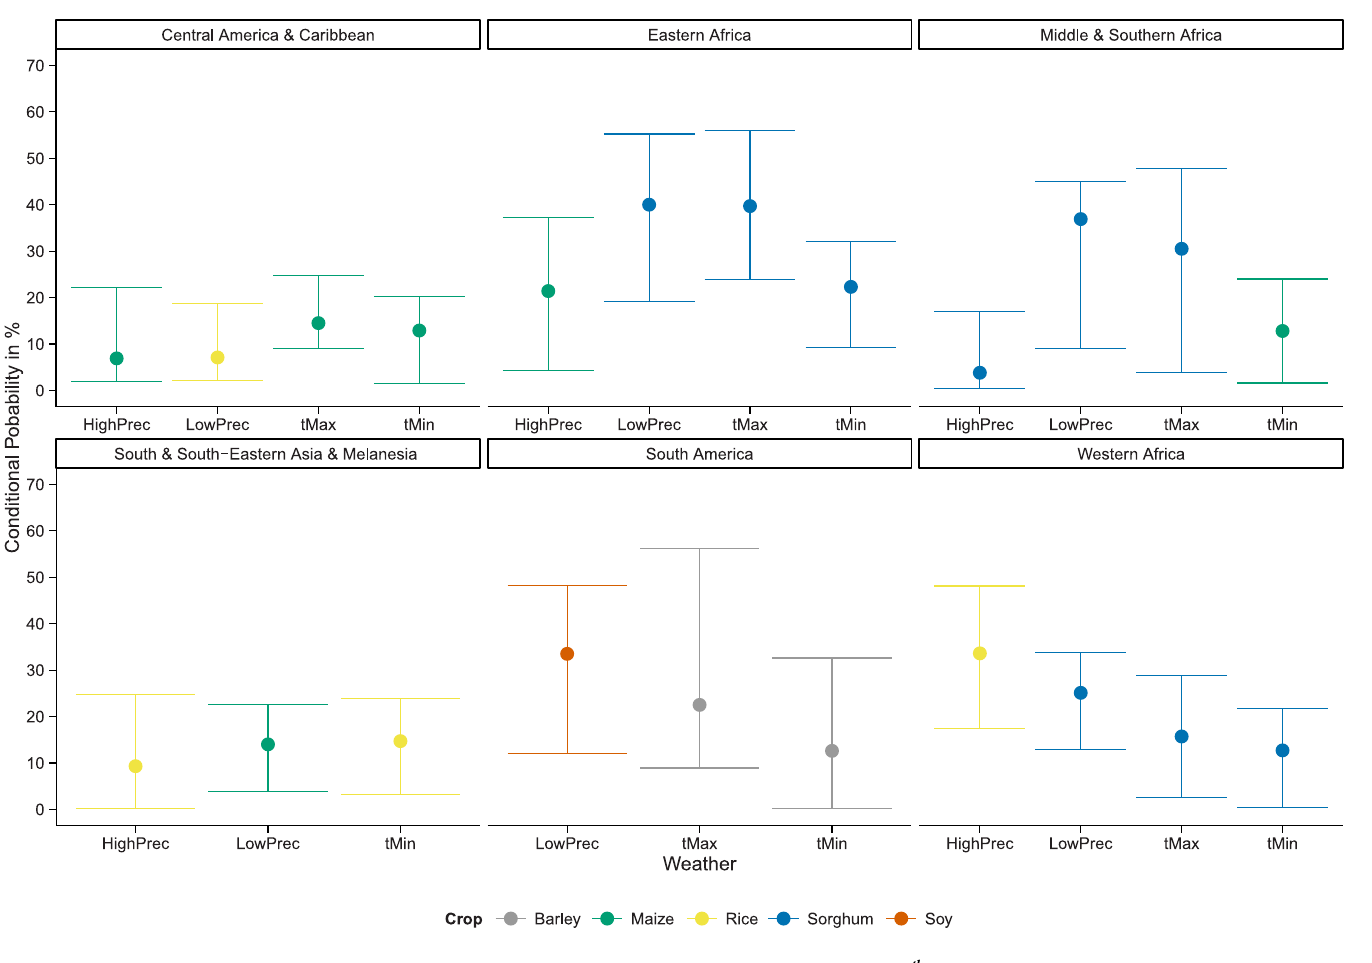
Fig 4. Highest point estimates of the conditional probabilities, i.e. the probabilities of yield losses above the 90 th quantile given minimum temperature, maximum temperature or high precipitation extremes above the 98 th quantile or low precipitation extremes below the 2 nd quantile. If the 95% confidence interval includes zero, the conditional probabilities are not